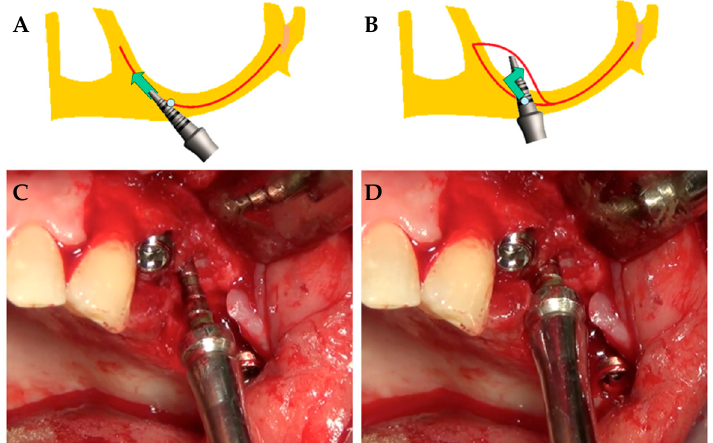
Figure 1. Augmented sinus by backward displacement technique of the anterior wall: ( A , B ) Procedure scheme for the surgical treatment; ( C , D ) clinical photograph showing the edentulous ridge of the maxilla with expansion devices in action.